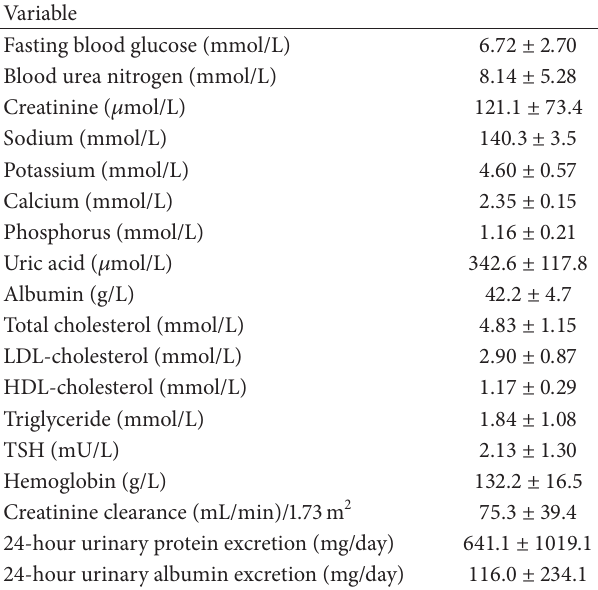
Table 2: The laboratory parameters of 139 patients. Variable